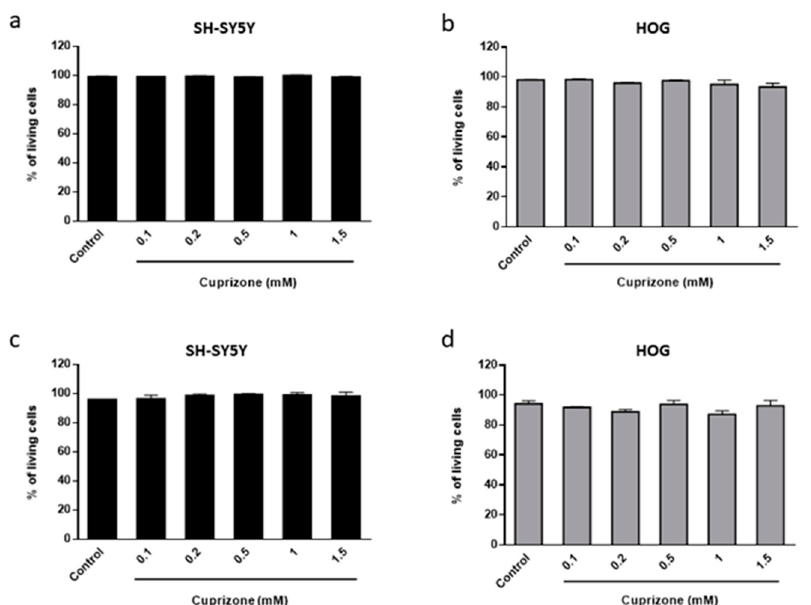
Figure 2. The number of SH-SY5Y ( a , c ) and HOG ( b , d ) living cells was calculated after 24 ( a , b ) and 48 h ( c , d ) of culture with increasing concentrations of CPZ (0.1–1.5 mM). Cell viability is represented as the percentage of living cells versus control. Data are the mean ± S.E.M of three independent experiments. Each experimental group was run in triplicate, and each plate was counted at least three times.